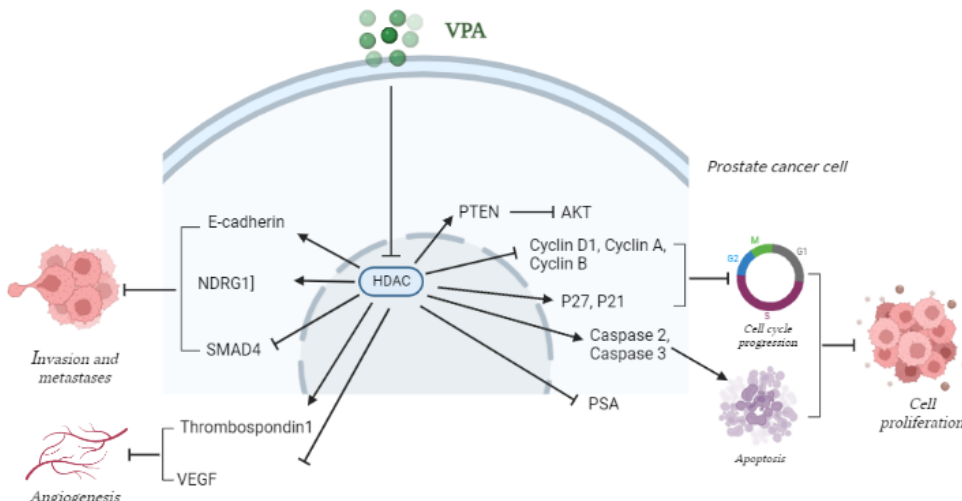
Figure 3. VPA anti-tumor activity in PCa. VPA inhibits HDACs activity. The deriving histone acet- ylation results in the induction or inhibition of several molecular targets, which are involved in PCa proliferation and progression, as well as in